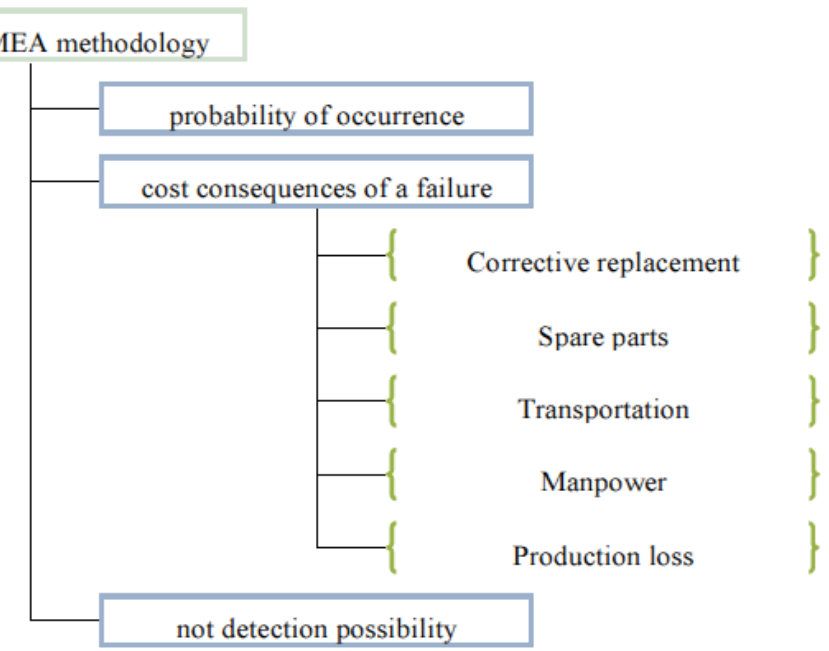
Figure 4. Components of the proposed FMEA methodology for wind